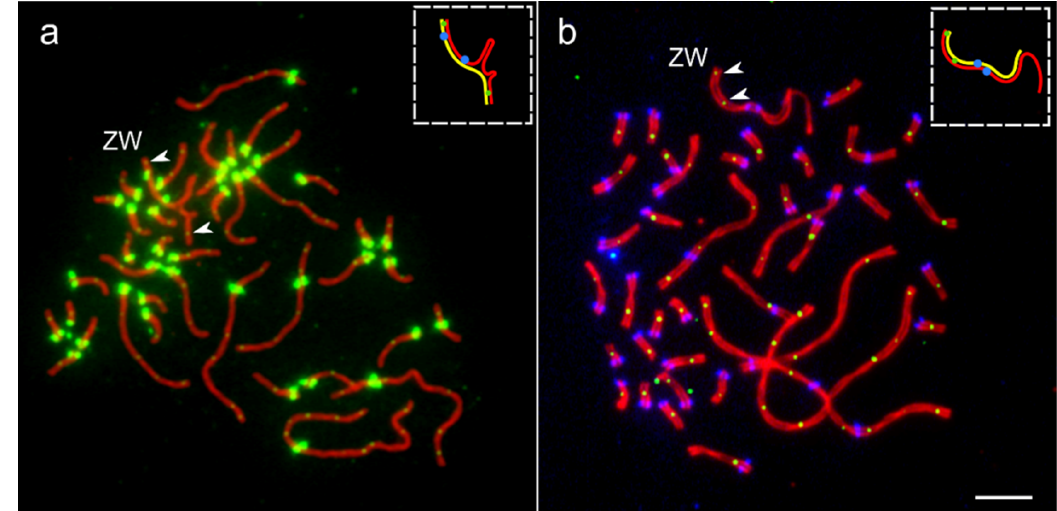
Figure 3. Two exceptional oocytes with two MLH1 signals at ZW bivalents. ( a ) Pachytene oocyte of the white wagtail immunostained with antibodies against SYCP3 (red), MLH1 (small green dots) and centromeres (large green dots). ( b ) Pachytene oocyte of domestic chicken immunostained with antibodies against SYCP3 (red), MLH1 (small green dots) and centromeres (large blue dots). Arrowheads indicate MLH1 signals at ZW bivalents. Inserts show schematic representations of Z (red) and W (yellow) SCs. Bar—5 μ m.